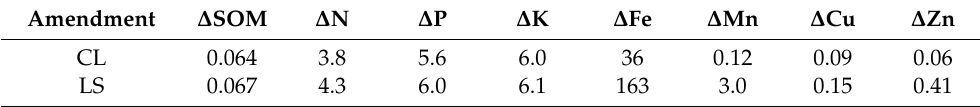
Table 7. Maximum increments of SOM and nutrients expected in the leonardite-amended soils ac- cording to the amendments’ rates, compositions and way of application (30-cm wide band application down to 30 cm depth, and soil bulk density of 1.5 g/cm 3 ). All increments in mg/kg except for SOM which is in